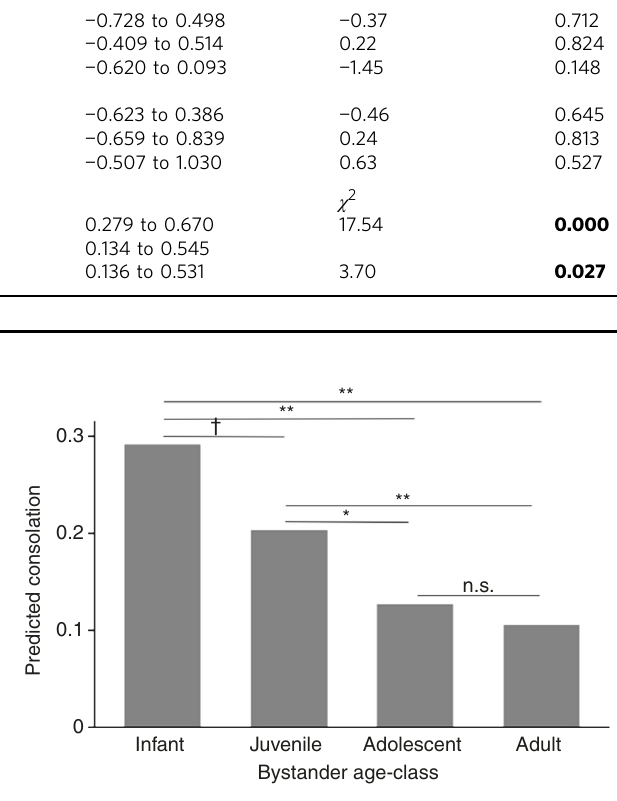
Fig. 1 Predicted probability of consolation by bystander age-class.